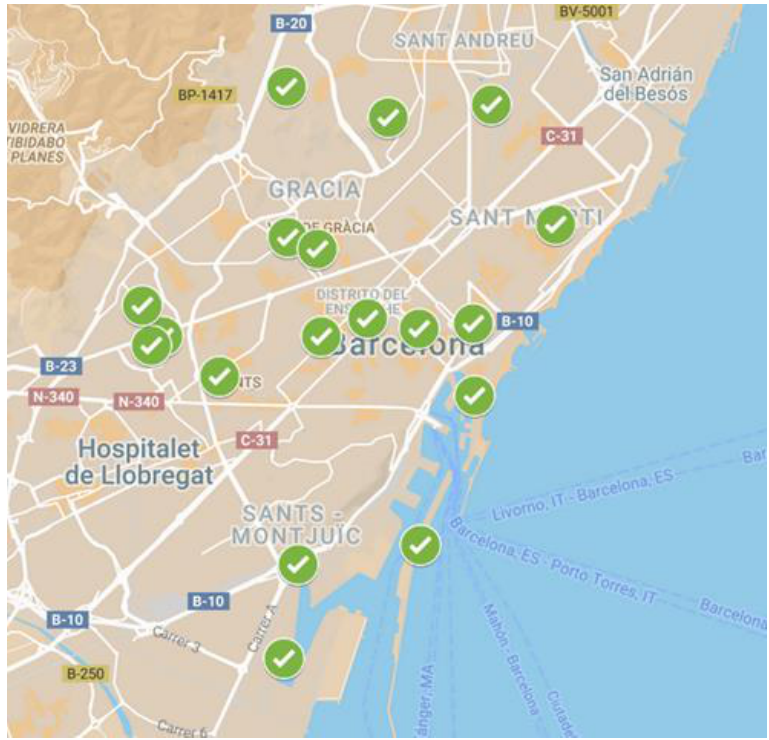
Figure 3. Map of Barcelona, showing the location of air pollution measuring points (green).